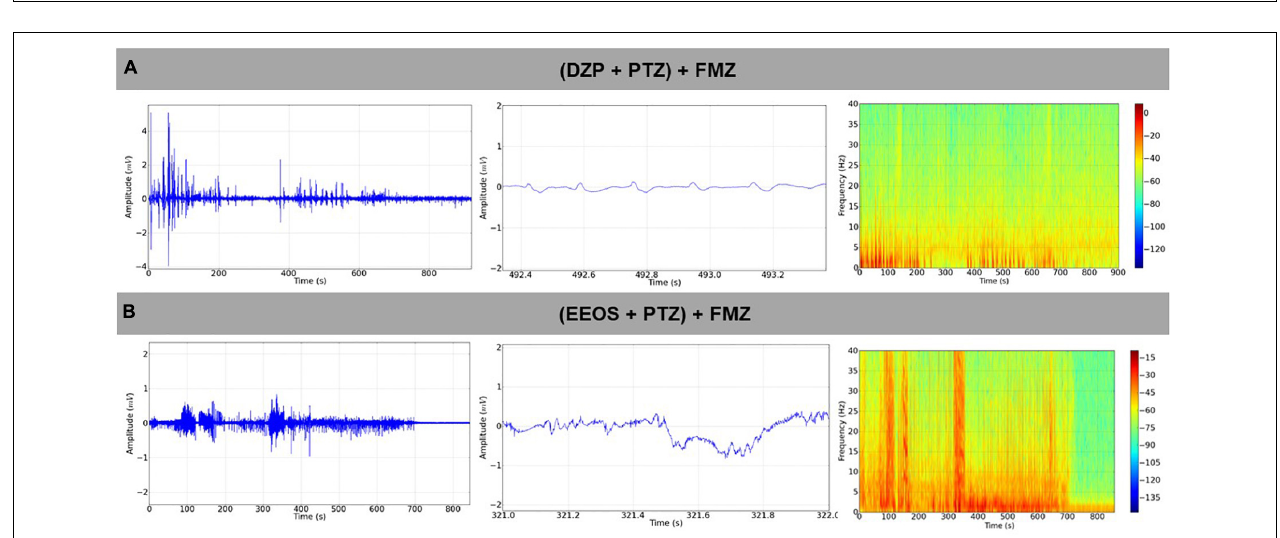
FIGURE 4 | Electrocorticographic (ECoG) tracing after the antagonization of diazepam (DZP) action by flumazenil (FMZ) causing the reappearance of tracings compatible with a convulsive condition (A) , seizure reappearance after the administration of FMZ in extract of Euterpe oleracea stones (EEOS)-controlled seizures (B) .